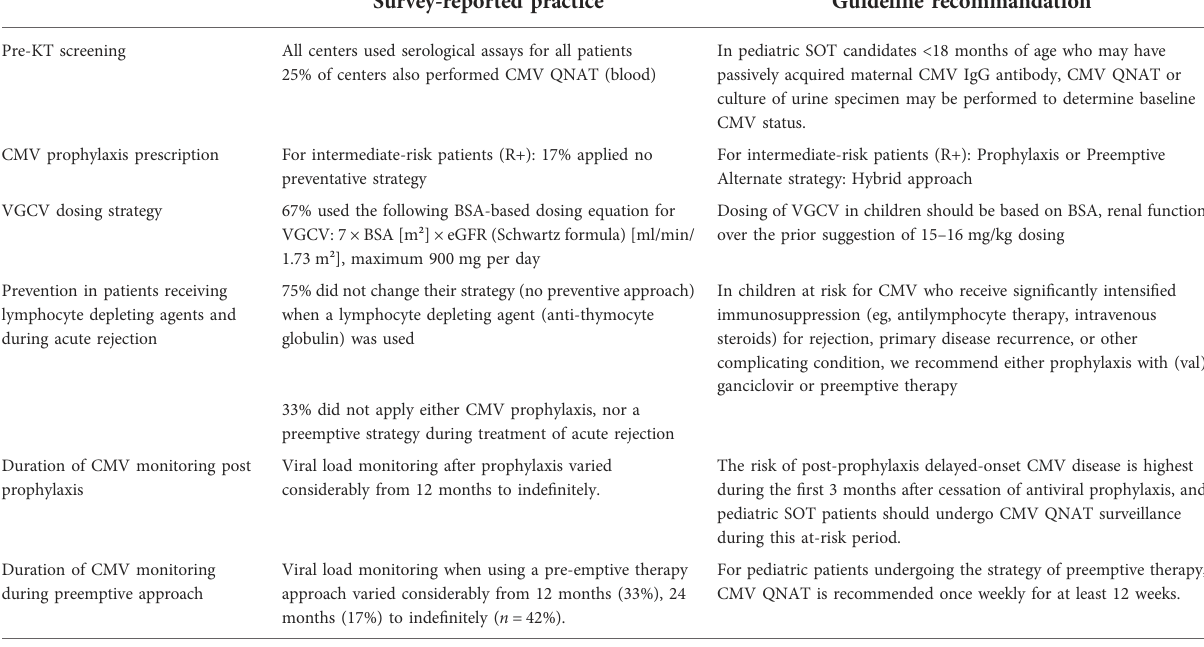
TABLE 3 Discrepancies between survey-reported practices and speci fi c pediatric guideline recommendations* Survey-reported